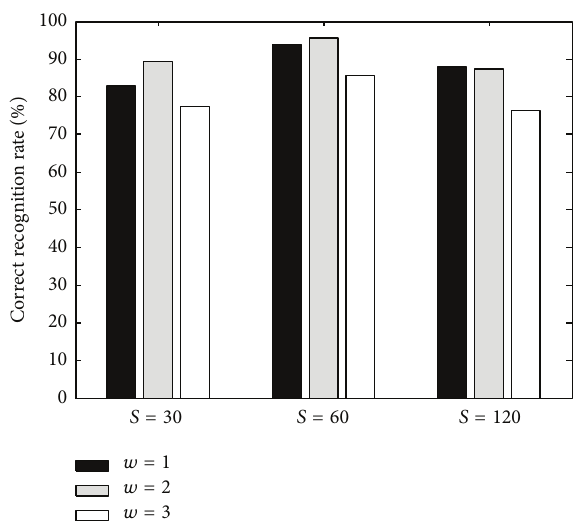
Figure 5: Comparison of correct recognition rate with 𝑆 = 30, 60, 120 ; 𝑤 = 1, 2 and 3 .